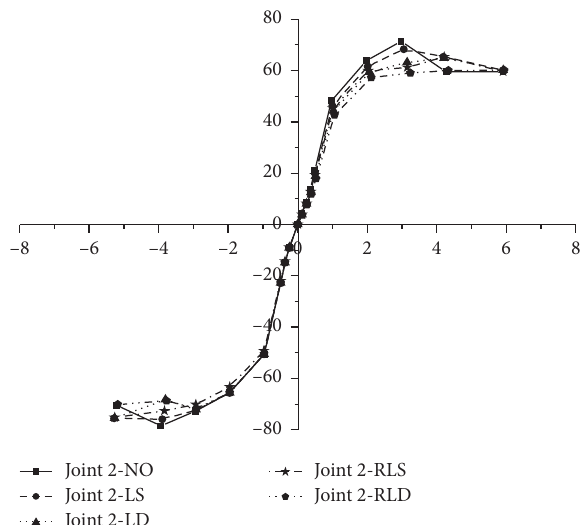
Figure 18: Comparisons of skeleton curves for Joint 2.